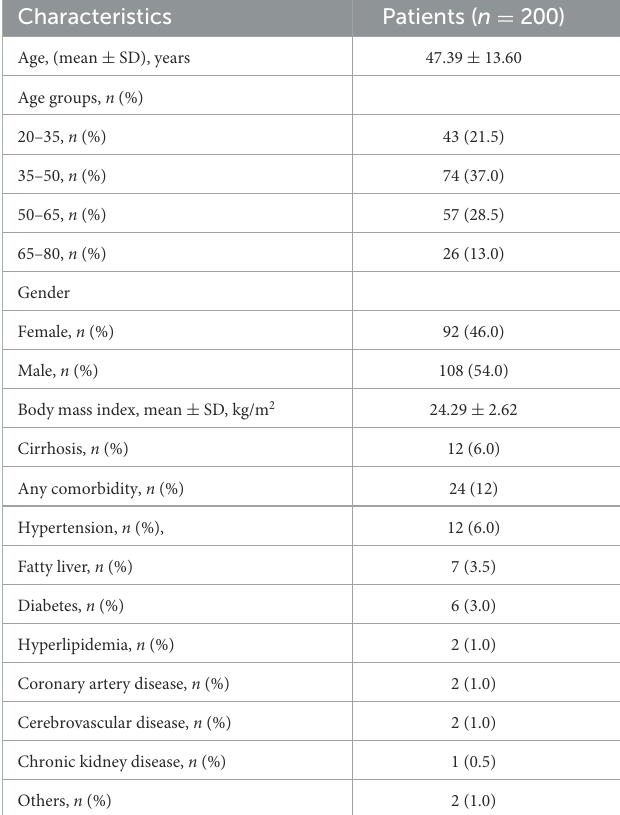
TABLE 1 Baseline characteristics of study